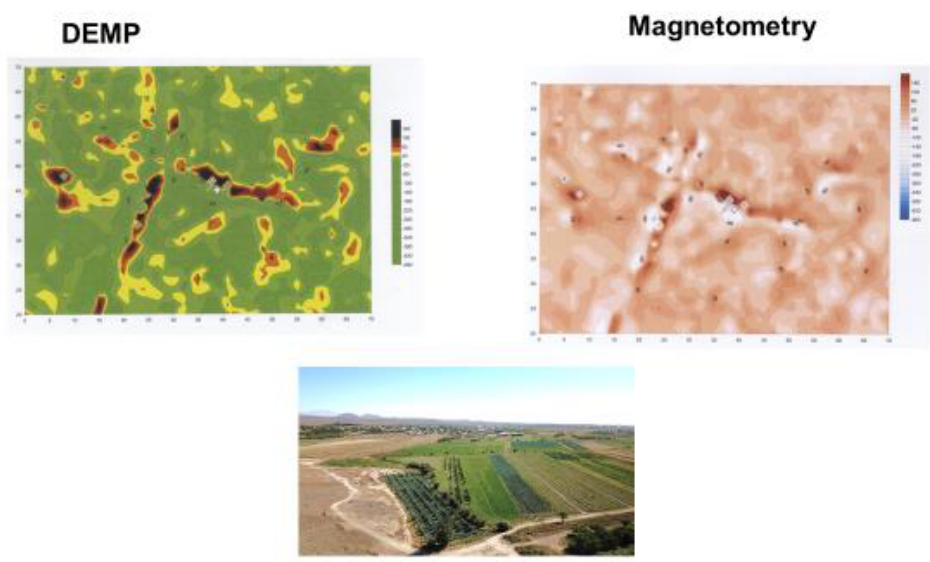
Figure 27. Ghanjyan Blur. Example of the detailed measurement with indication of two 2D structures (possibly walls).